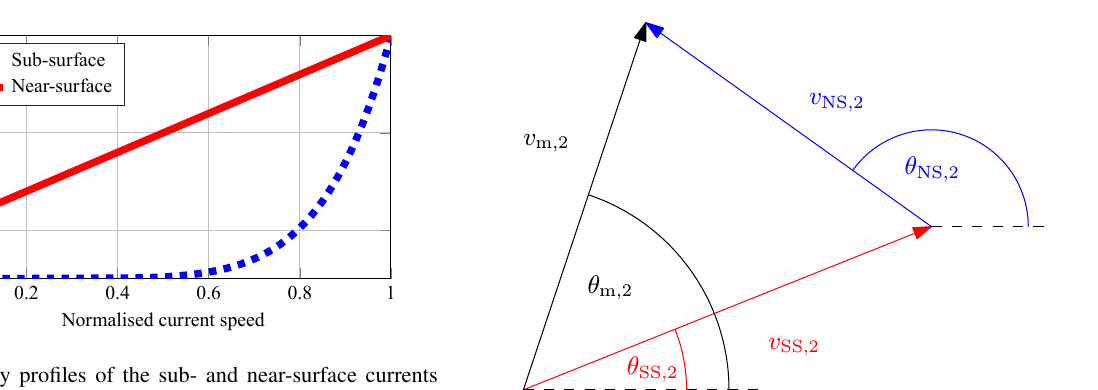
Figure 2. Velocity profiles of the sub- and near-surface currents according to Eqs. (7) and (8) respectively, with a water depth of 25m and normalised speeds ( v SS,0 = v NS,0 = 1). Figure 3. Vectorial analysis of ocean current components at a depth